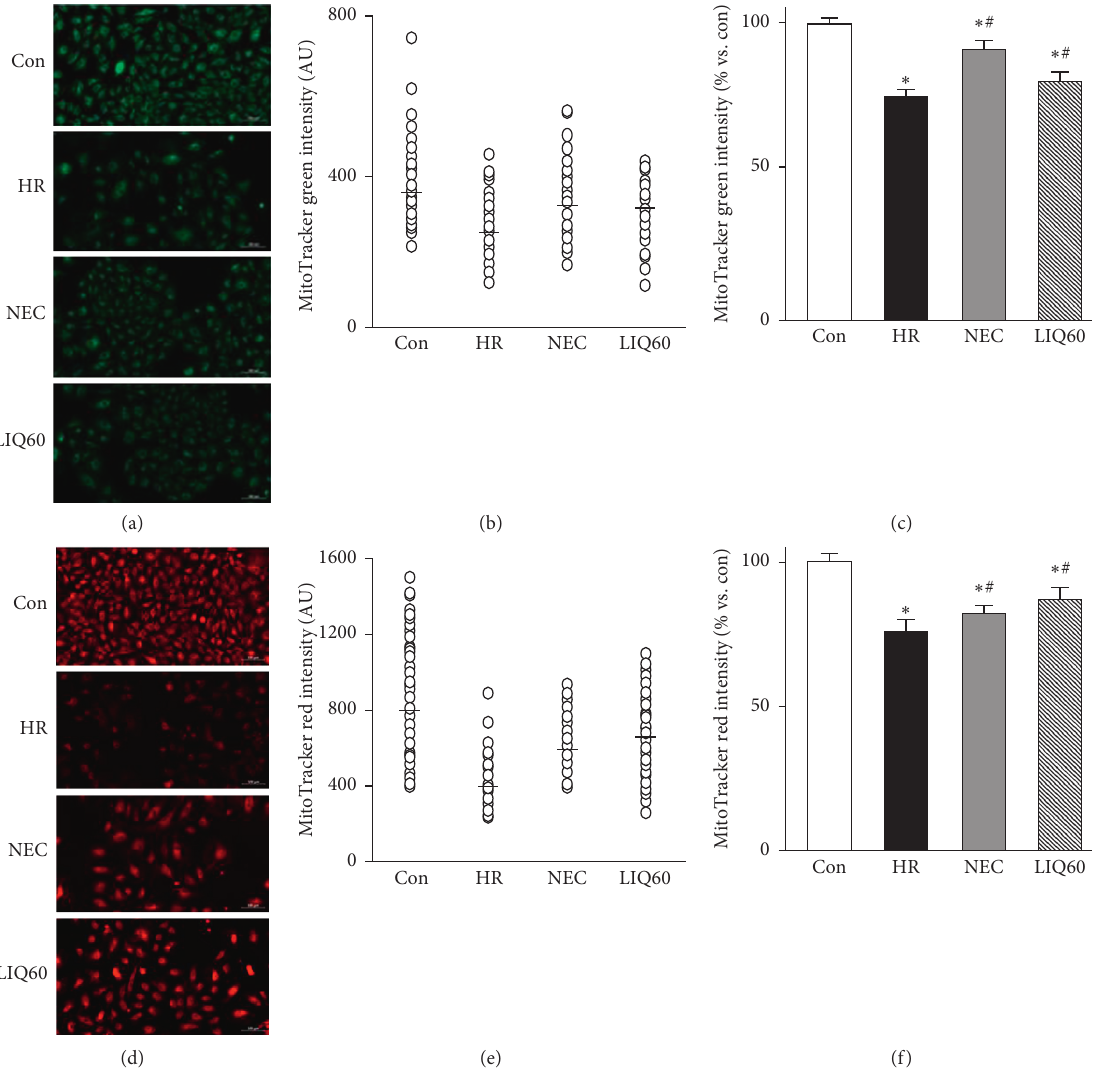
Figure 3: Mitochondrial mass in H9C2 cells subjected to different treatments. (a) Representative images of H9C2 cells stained with MitoTracker Green. (b) The graph indicates MitoTracker green fluorescence intensity per cell ( ○ , open circle) of the representative images. (c) The graph indicates the total MitoTracker green intensity. (d) Representative images of H9C2 cells stained with MitoTracker red. (e) The graph indicates MitoTracker red fluorescence intensity per cell ( ○ , open circle) of the representative images. (f) The graph indicates the total MitoTracker red intensity. AU: arbitrary unit; Con: normal control; HR: hypoxia/reoxygenation; NEC: HR +NecroX-5; LIQ60: HR +LIQ at a dose of 60 μ M; ∗ p < 0 . 05 vs. Con; # p < 0 . 05 vs. HR; n � 3; scale bar 100 μ